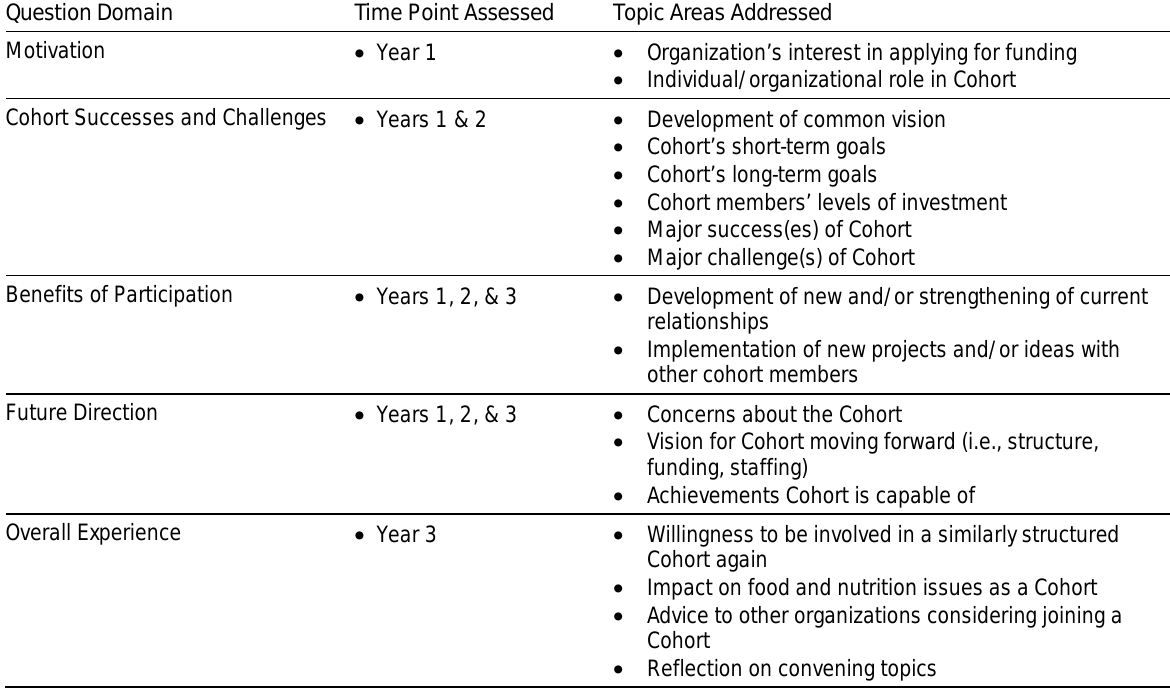
Table 2. Cohort Member Key Informant Interview Question